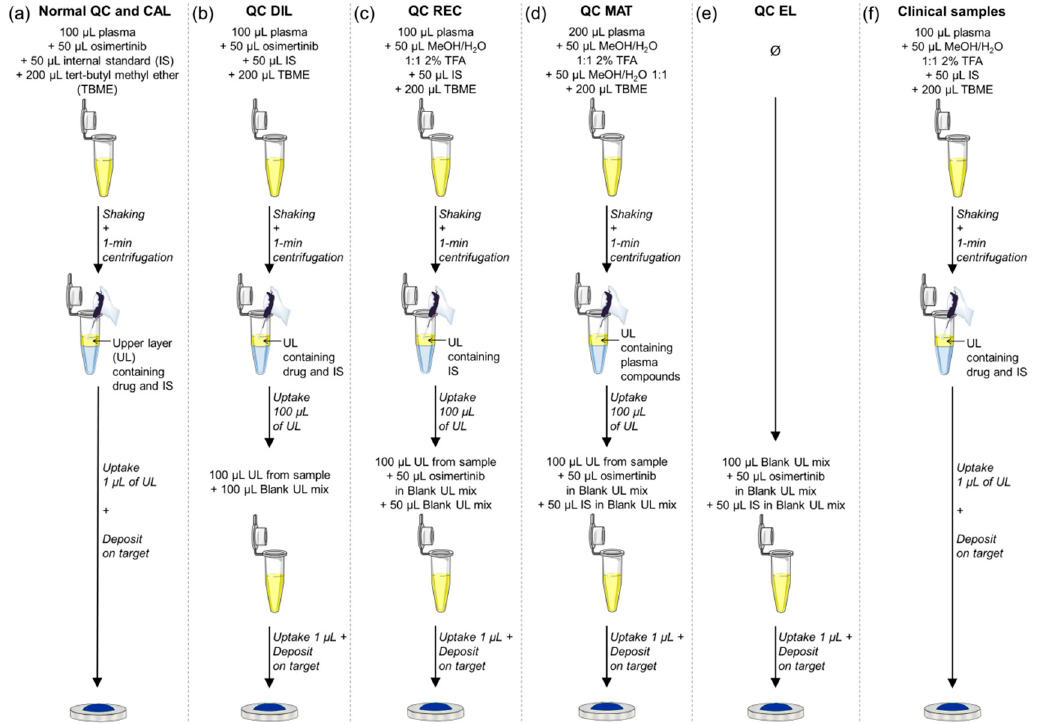
Figure 6. Detailed workflow for the preparation of the quality control (QC), calibration standard (CAL), and clinical samples during validation and analytical batches of the matrix-assisted laser desorption/ionization–ion mobility–tandem mass spectrometry (MALDI–IM–MS/MS) assay for osimertinib quantification. ( a ) Preparation of CAL samples for all batches and normal QC samples for accuracy and precision batches, and for analytical batches. ( b ) Preparation of QC DIL (diluted QC) samples for recovery experiments. ( c ) Preparation of QC REC (QC recovery) samples for recovery experiments (corresponding to the hypothesis of total extraction of osimertinib using the liquid–liquid extraction process). ( d ) Preparation of QC MAT (QC matrix) samples for the matrix effect experiments. ( e ) Preparation of the QC EL (QC eluent) for the matrix effect experiments. ( f ) Preparation of the clinical samples for the analytical batches.